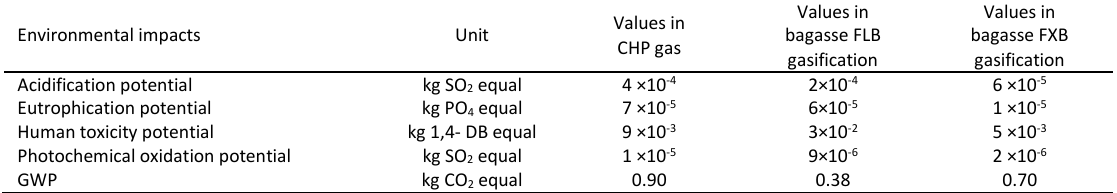
Table 1: Environmental impacts of production of 1 kWh electricity in different power plants ( Mohammadi et al., Environmental impacts